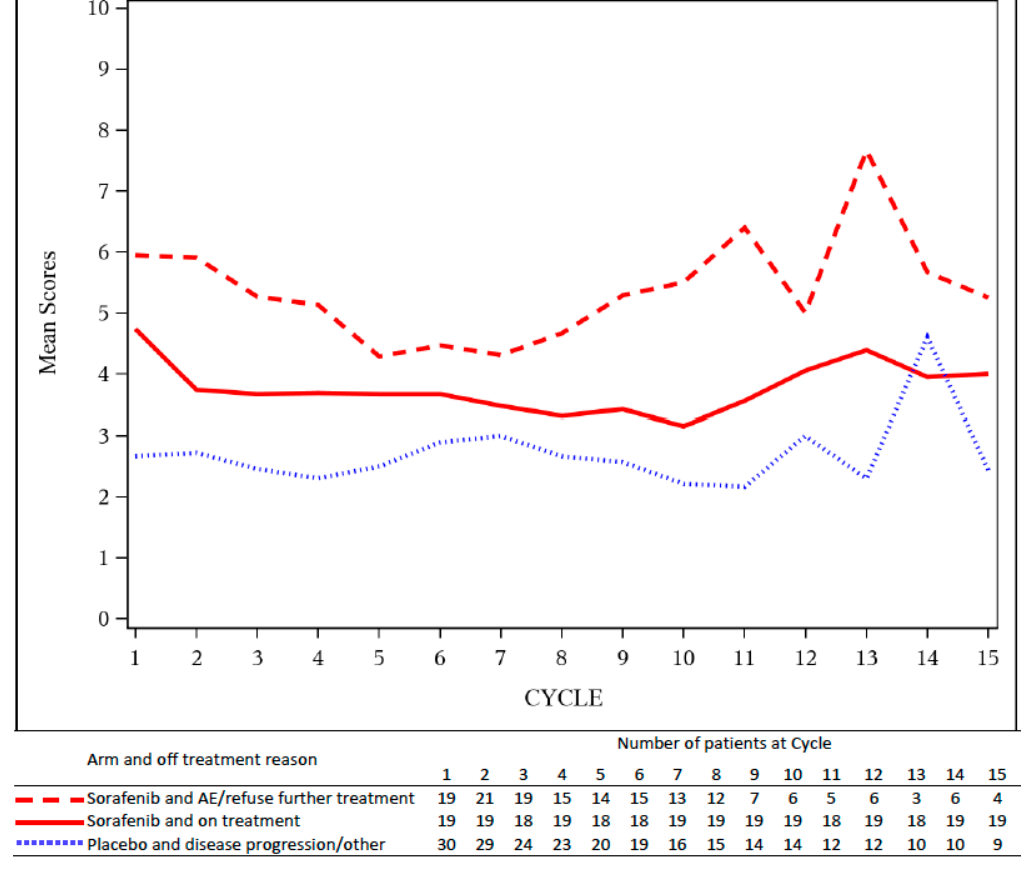
Figure 4. AE burden by treatment cycle, B(t) , grouped by off-treatment reason and treatment arm for A091105. The AE burden of patients on sorafenib who went off treatment due to adverse events (dashed red line) was higher than the AE burden of patients on sorafenib who remained on treatment (solid red line) or those on placebo who went off for disease progression (dotted blue line).